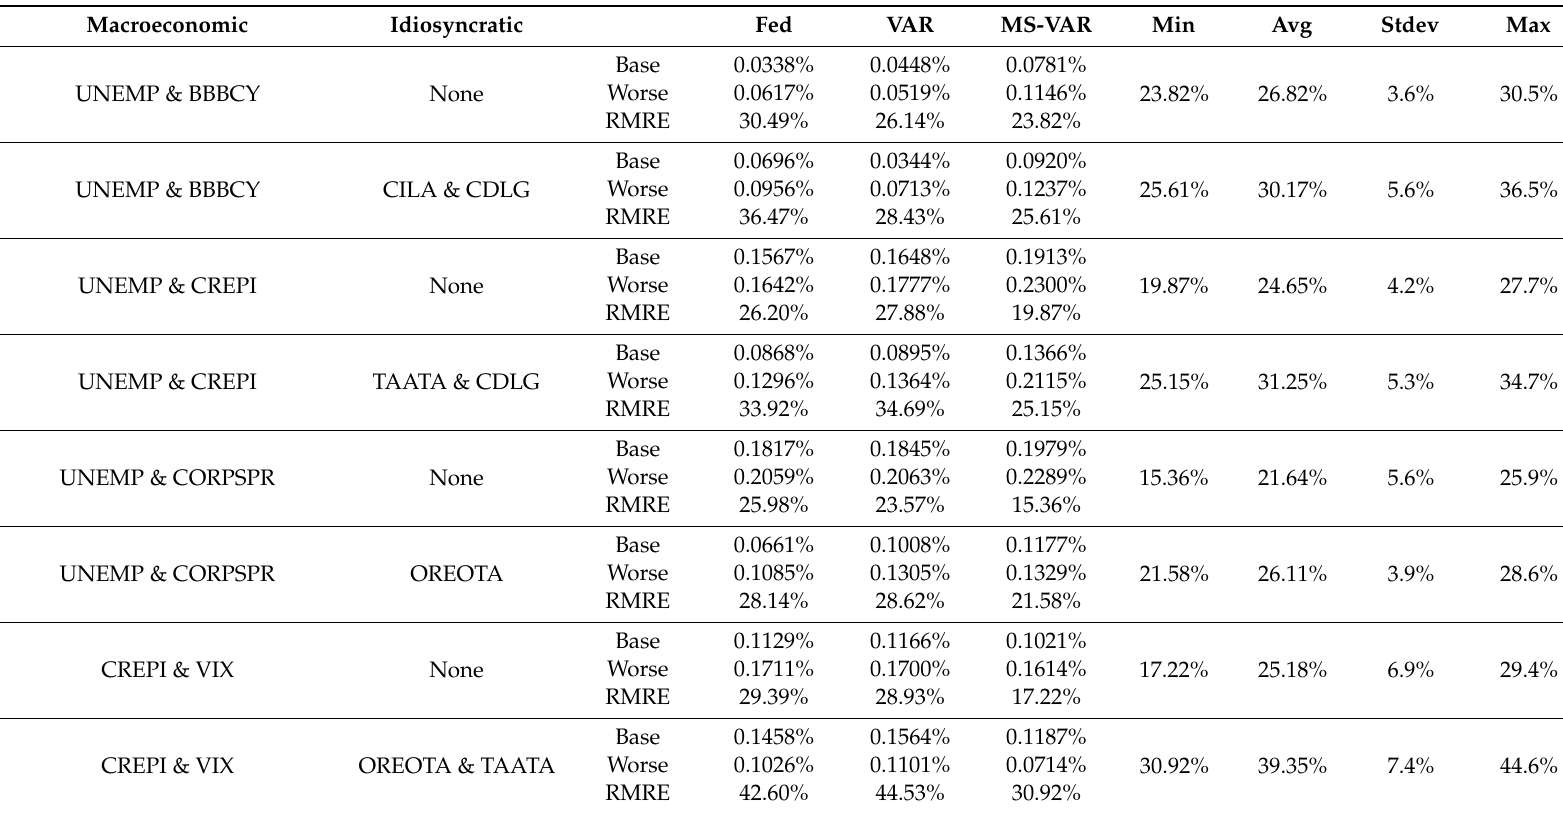
Table 5. Kullback–Leibler relative entropy worst-case loss for model risk quantification measures—vector autoregressive CECL out-of-sample models compared (FDIC SDI Report, Federal Reserve Board 4Q91–4Q15, and Jacobs (2018)